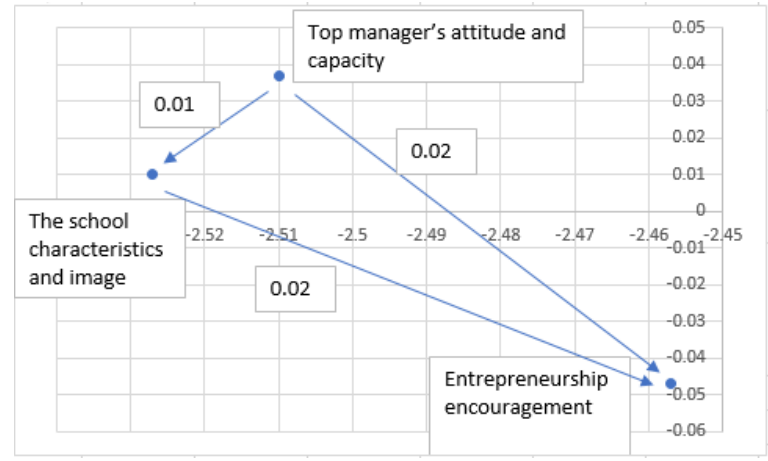
Figure 3. Causal diagram of sub-aspects of organizational culture. Table 4. The casual matrix of sub-aspects of organizational structure and